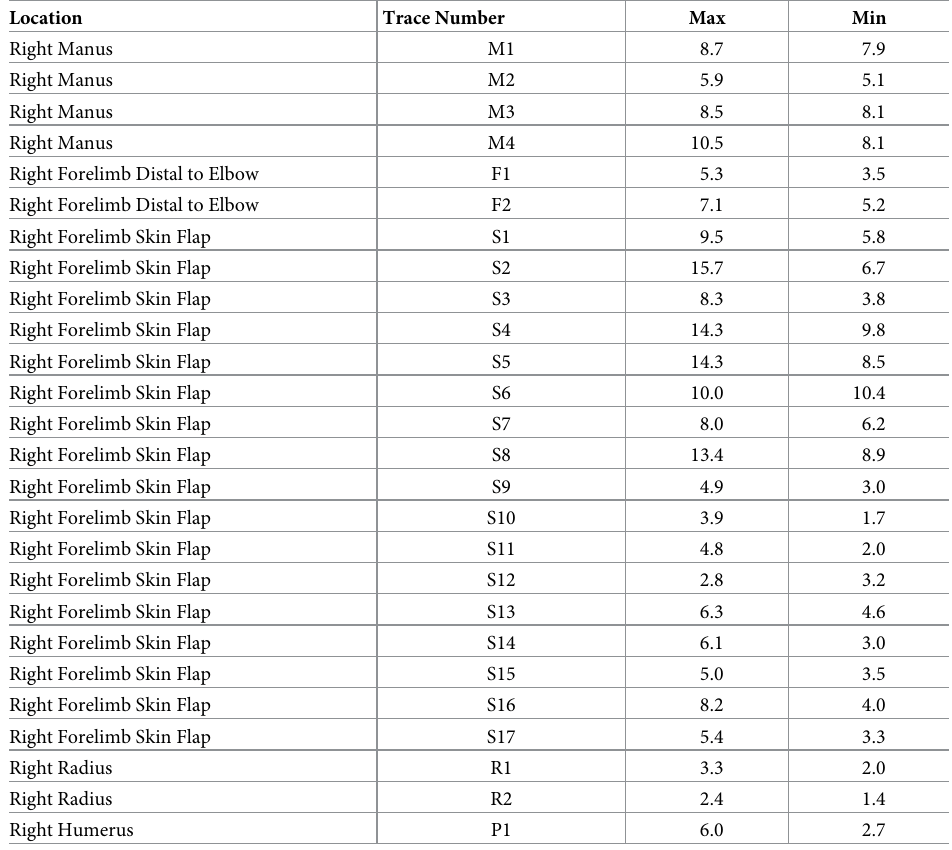
Table 1. Dimensions of feeding traces on NDGS 2000. Location Trace Number Max Min Right Manus M1 Right Manus Right Manus Right Manus